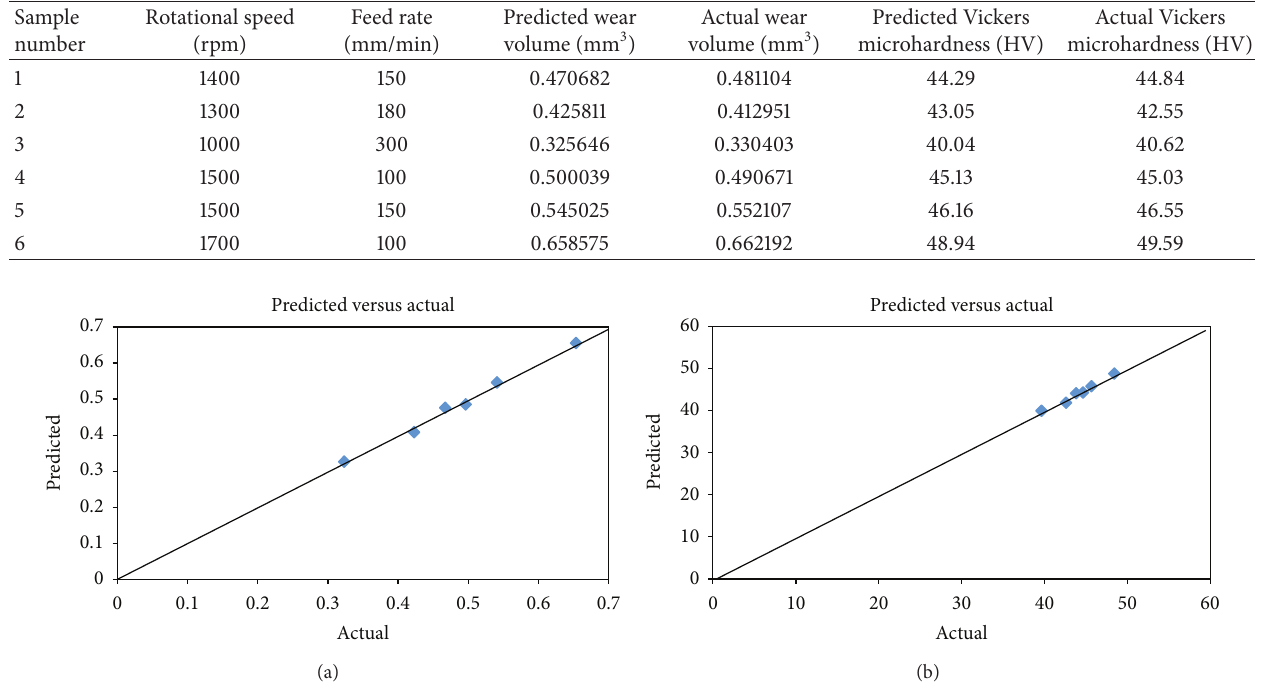
Table 7: Validation results.